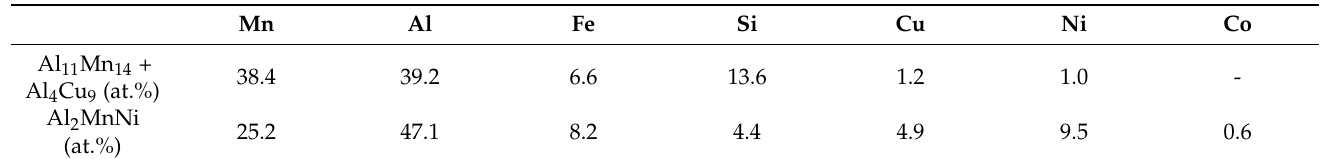
Table 6. Chemical composition of individual phases in alloy sintered at 900 °C and heat-treated by annealing at 800 °C.